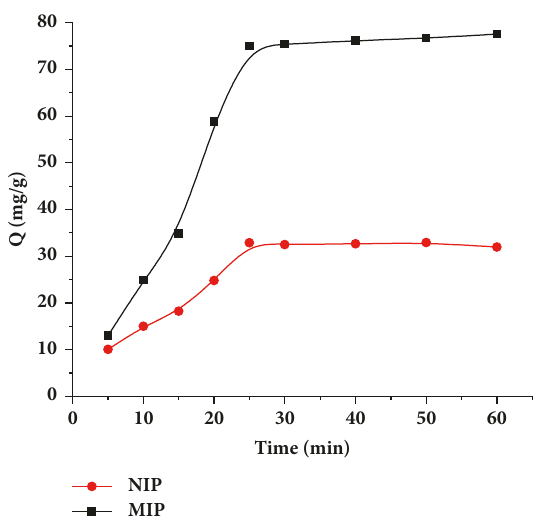
Figure 7: Dynamic adsorption